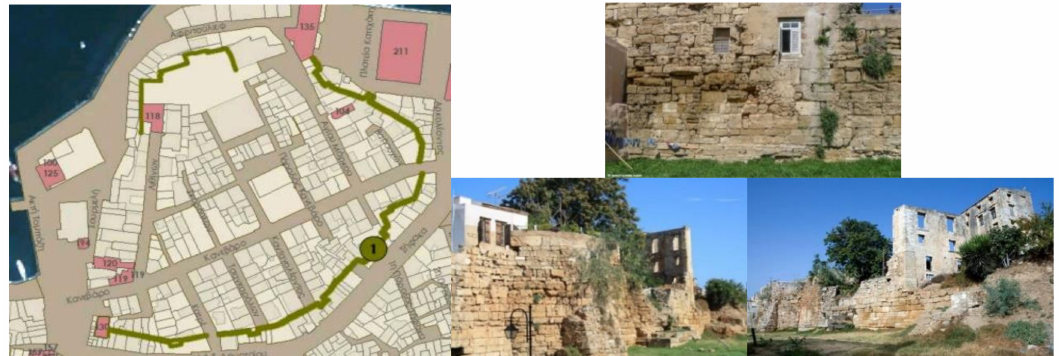
Figure 3. The Byzantine wall and the part chosen to be 3D modeled in green ( left ). The demolished and built over towers of the wall ( right